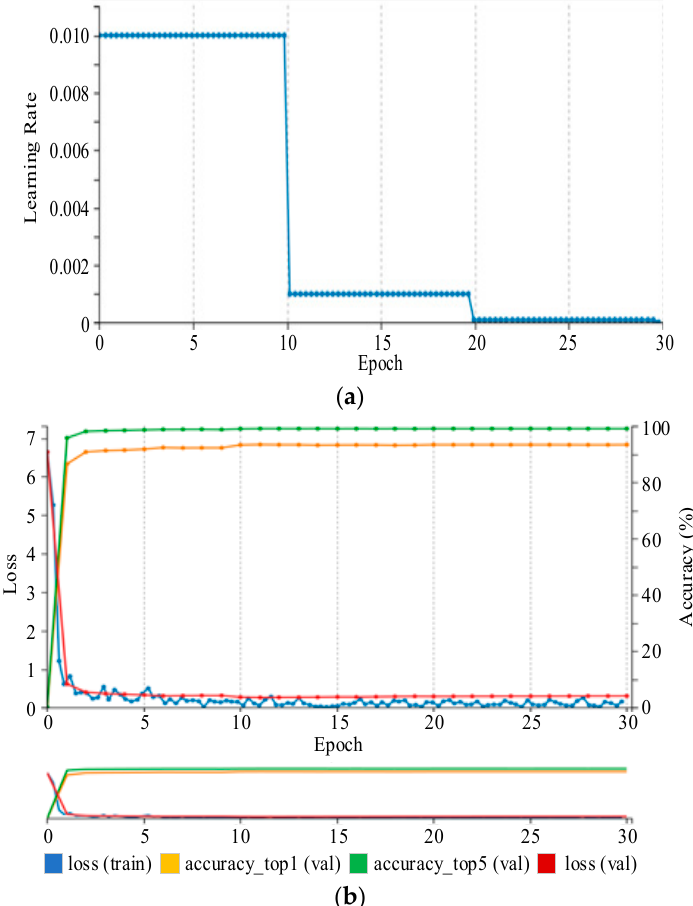
Figure 9. ( a ) Learning rate decay is visualized over training epochs. Here, a step function decay is used, and the learning rate is divided by 10 after one-third and two-thirds of training. ( b ) Training loss, validation loss and accuracy are plotted over training epochs.